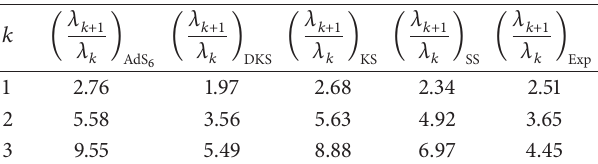
Table 1: The ratio of the obtained eigenvalues of (21) compared with the results of the KS [54], DKS [55], and SS model [18] and the ratio of meson